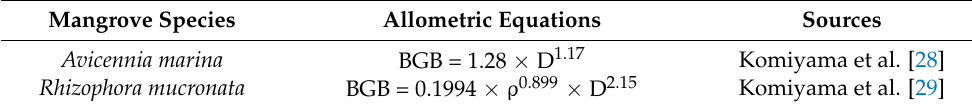
Table 2. Allometric equations for below-ground biomass estimation. Mangrove Species Allometric Equations